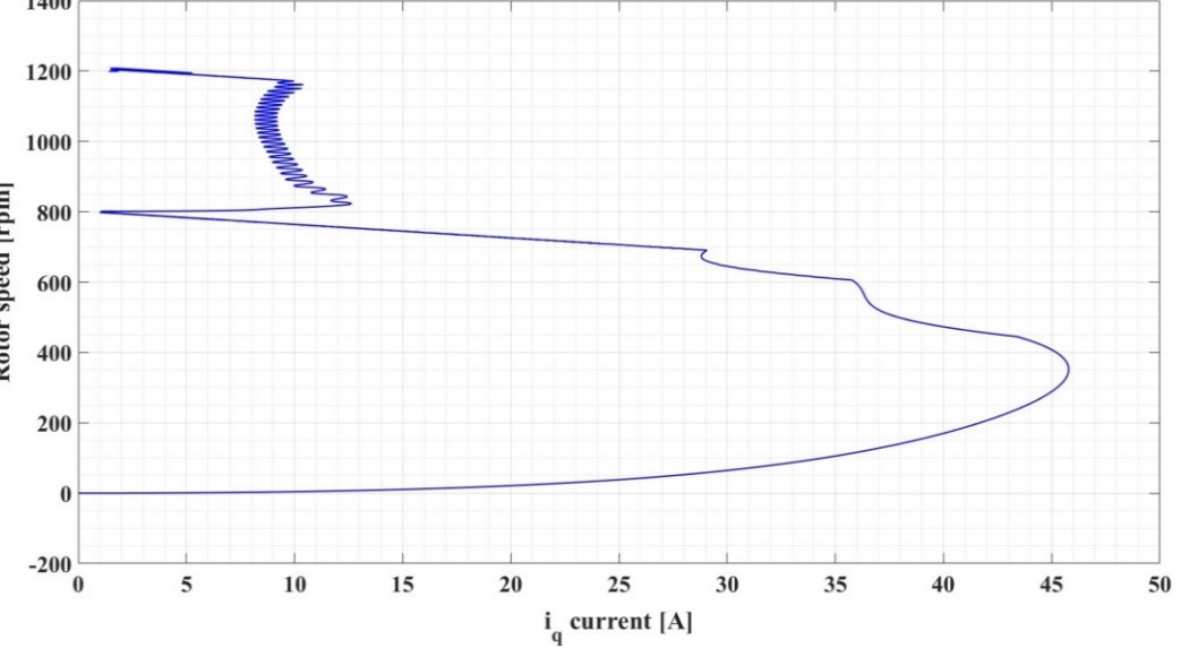
Figure 32. Image of the state space for PMSM variable structure with switching signal type 2: rotor speed versus i q current versus i d current ( ω ref = 800 rpm).